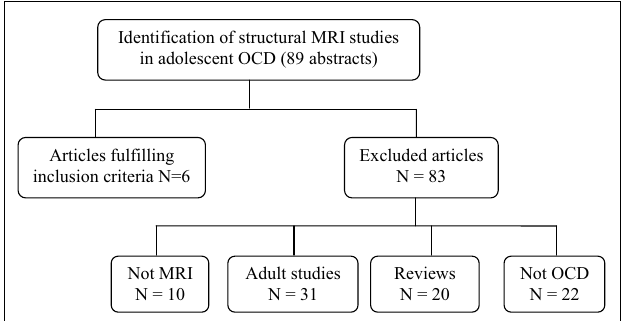
FIGURE 1 |Article selection process of structural magnetic resonance imaging studies in obsessive compulsive disorder in children and adolescents.